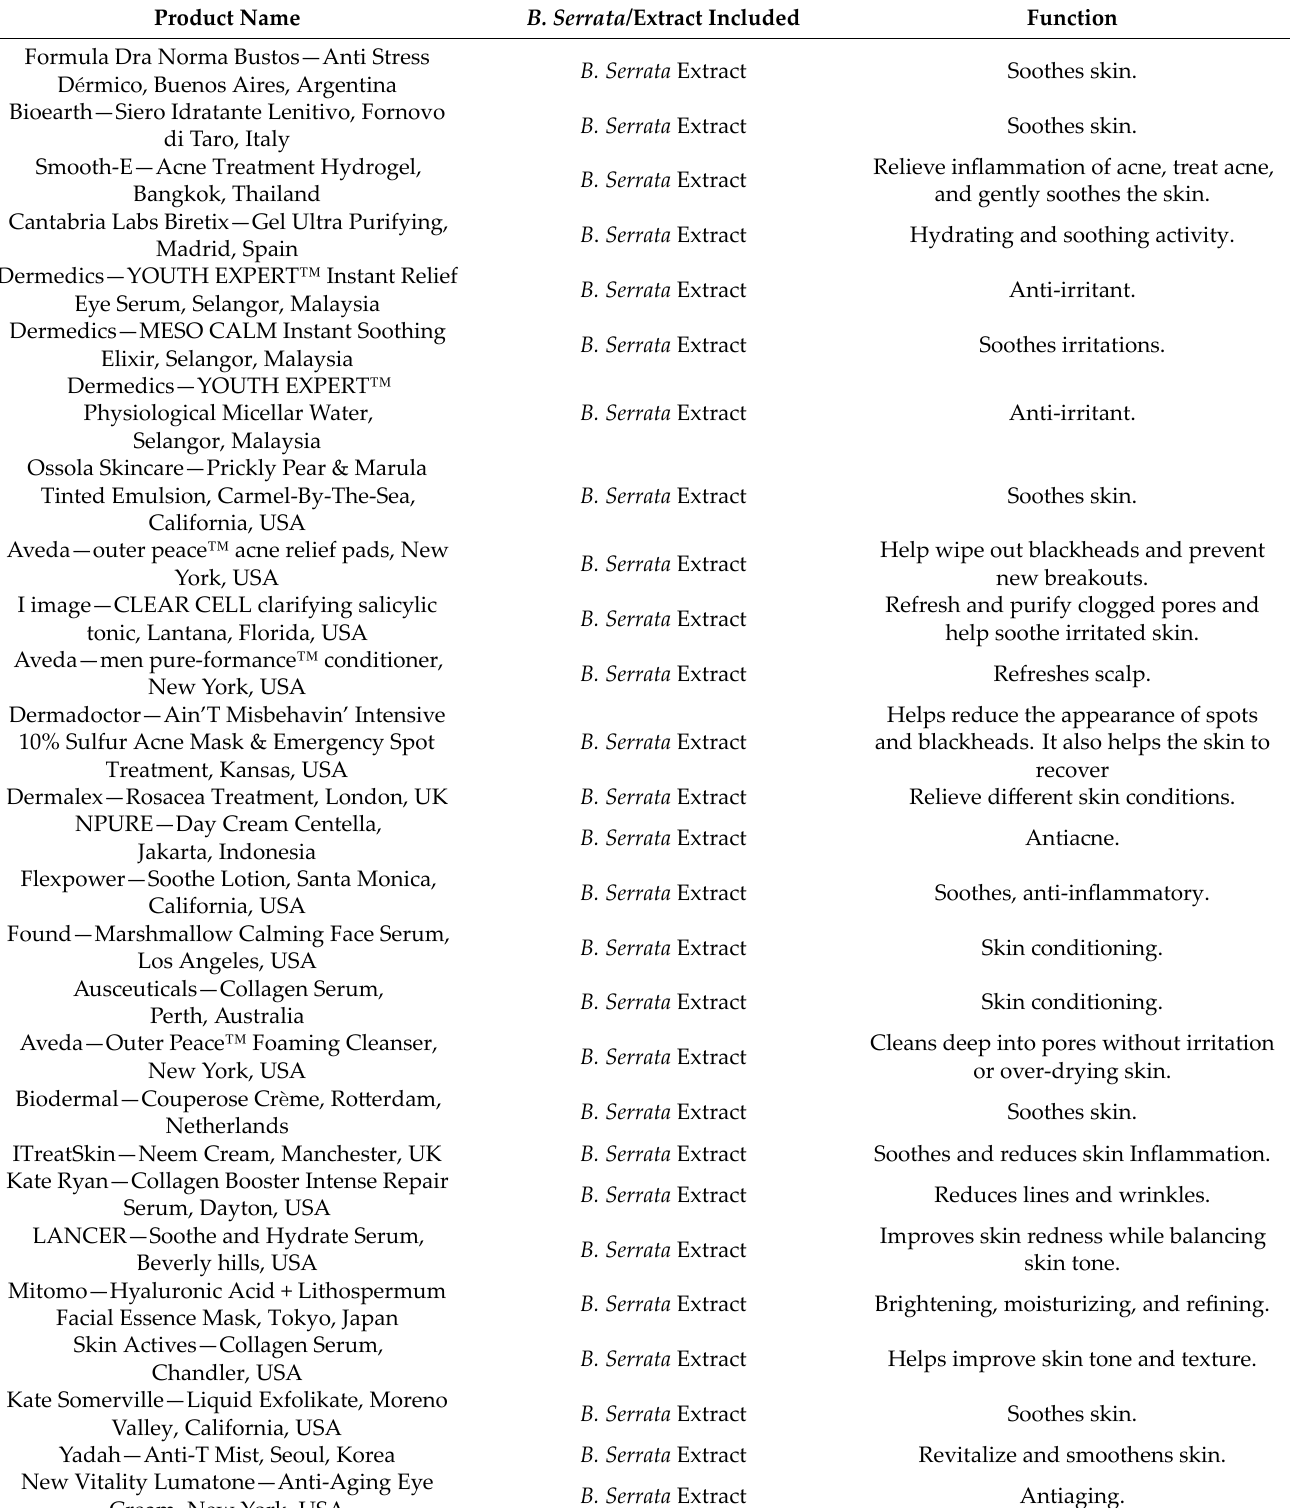
Table 3. Cosmetic products containing B. Serrata